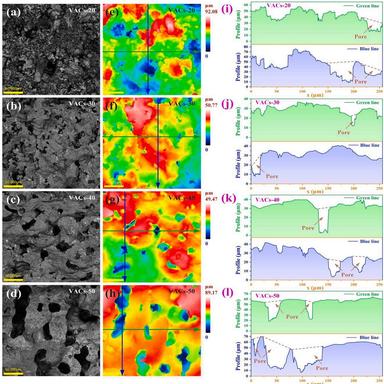
Typical pore morphology of VACs specimens with different WTPS additions: (a-d) CLSM optical micrograph; (e-h) Height distribution map; (i-l) Fracture surface profile.